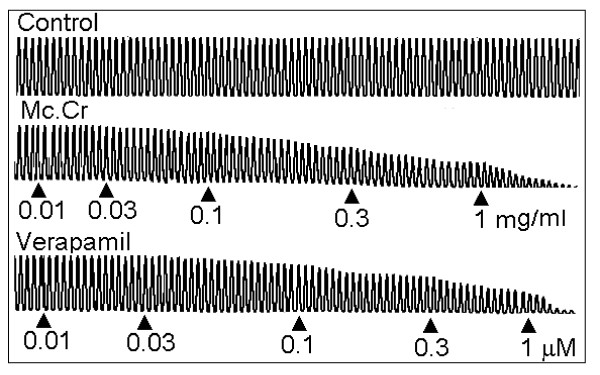
Typical tracing showing inhibitory effect of crude extract of Morinda citrifolia (Mc.Cr) and verapamil on the spontaneous contractions in isolated rabbit jejunum preparations.